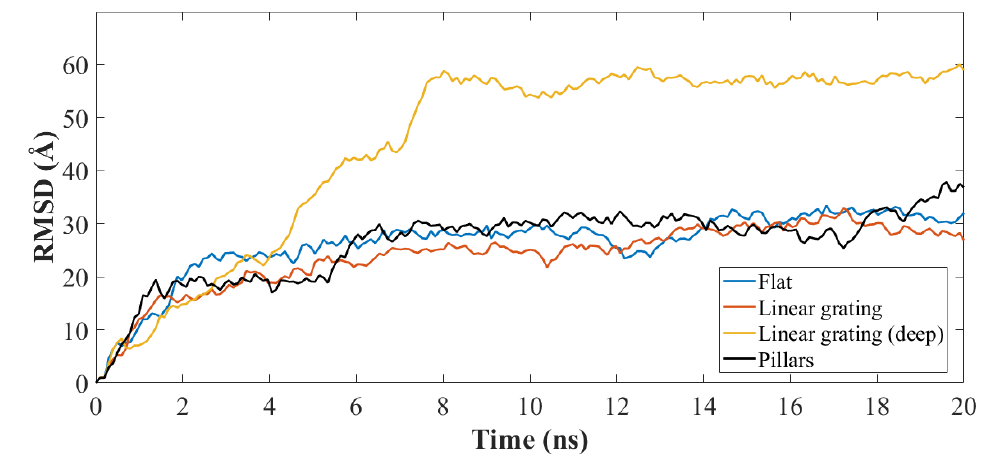
linear-grating structures.